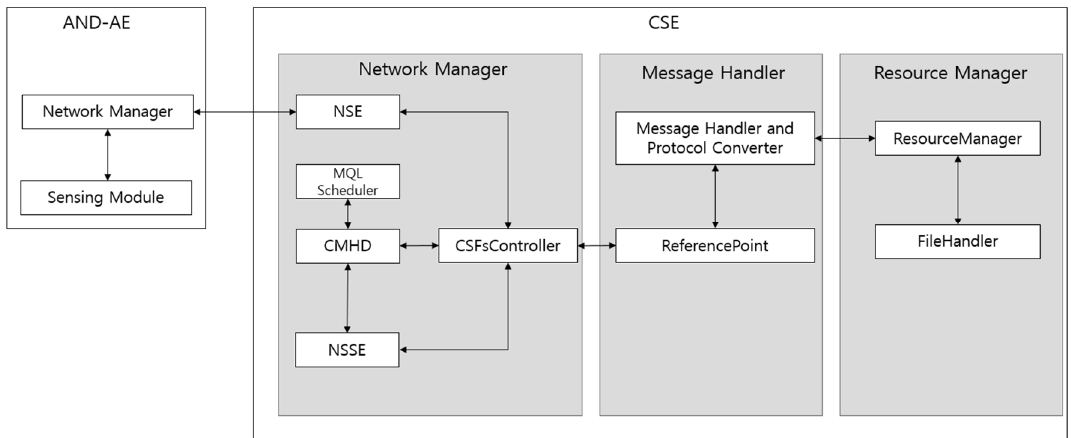
Figure 2. Internal structure of the oneM2M (Machine-to-Machine) IoT system.